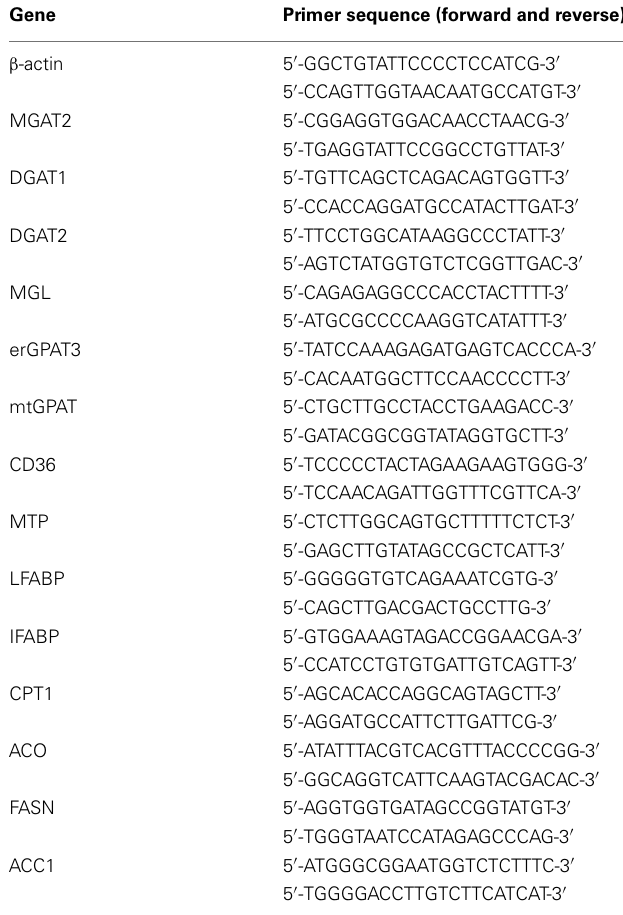
Table 2 | Primer sequences used for qRT-PCR analyses. Gene Primer sequence (forward and